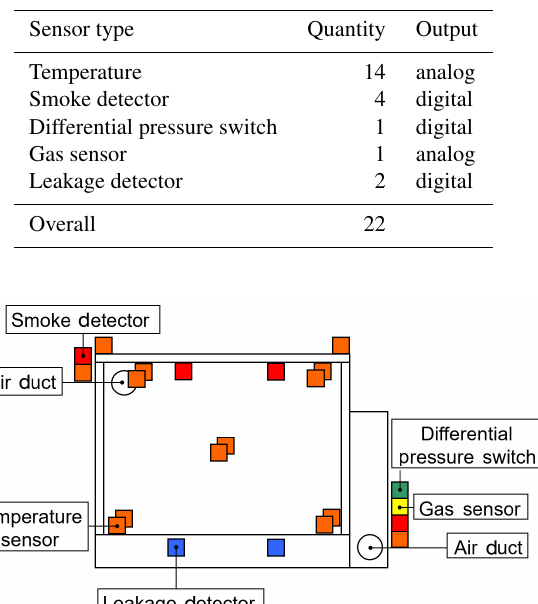
Table 1. List of all sensors applied to the hazardous material store.